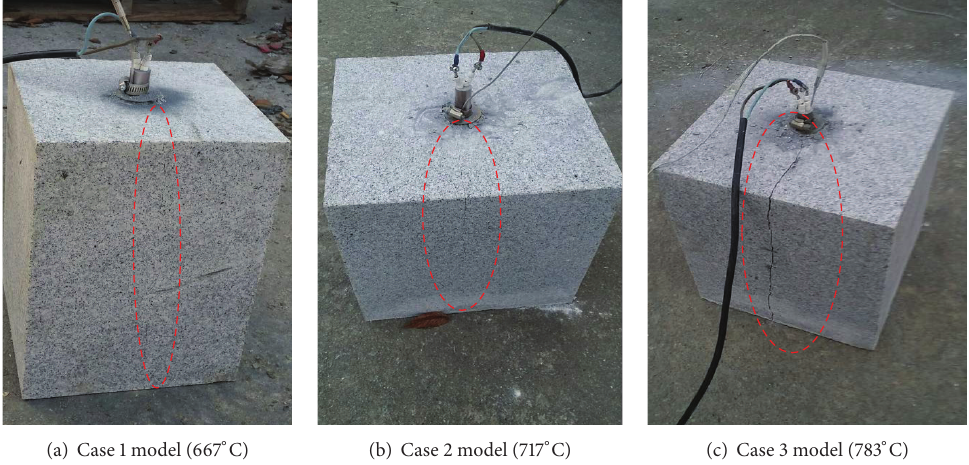
Figure 6: Initial cracking (IC) images of massive granite subjected to uniform internal